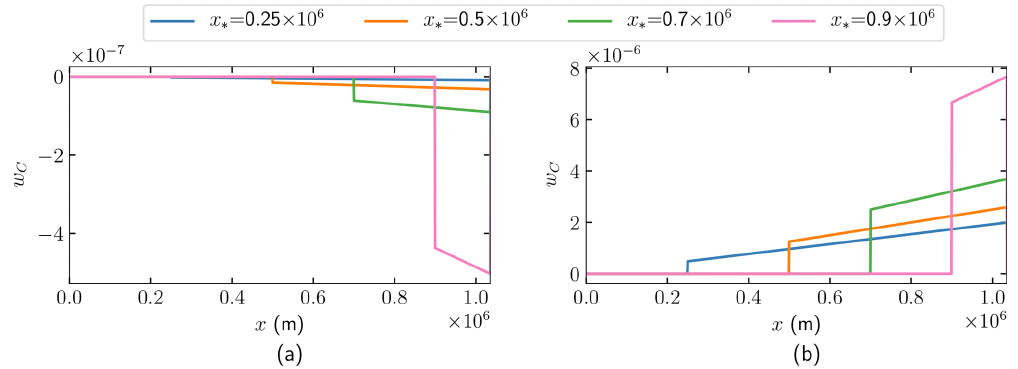
Figure 6. The analytical solution of the weights w C = − vu m on δC in (38) for (a) u and (b) h observed at x ∗ = 0 . 25 × 10 6 , 0 . 5 × 10 6 , 0 . 7 × 10 6 , and 0 . 9 × 10 6 m.